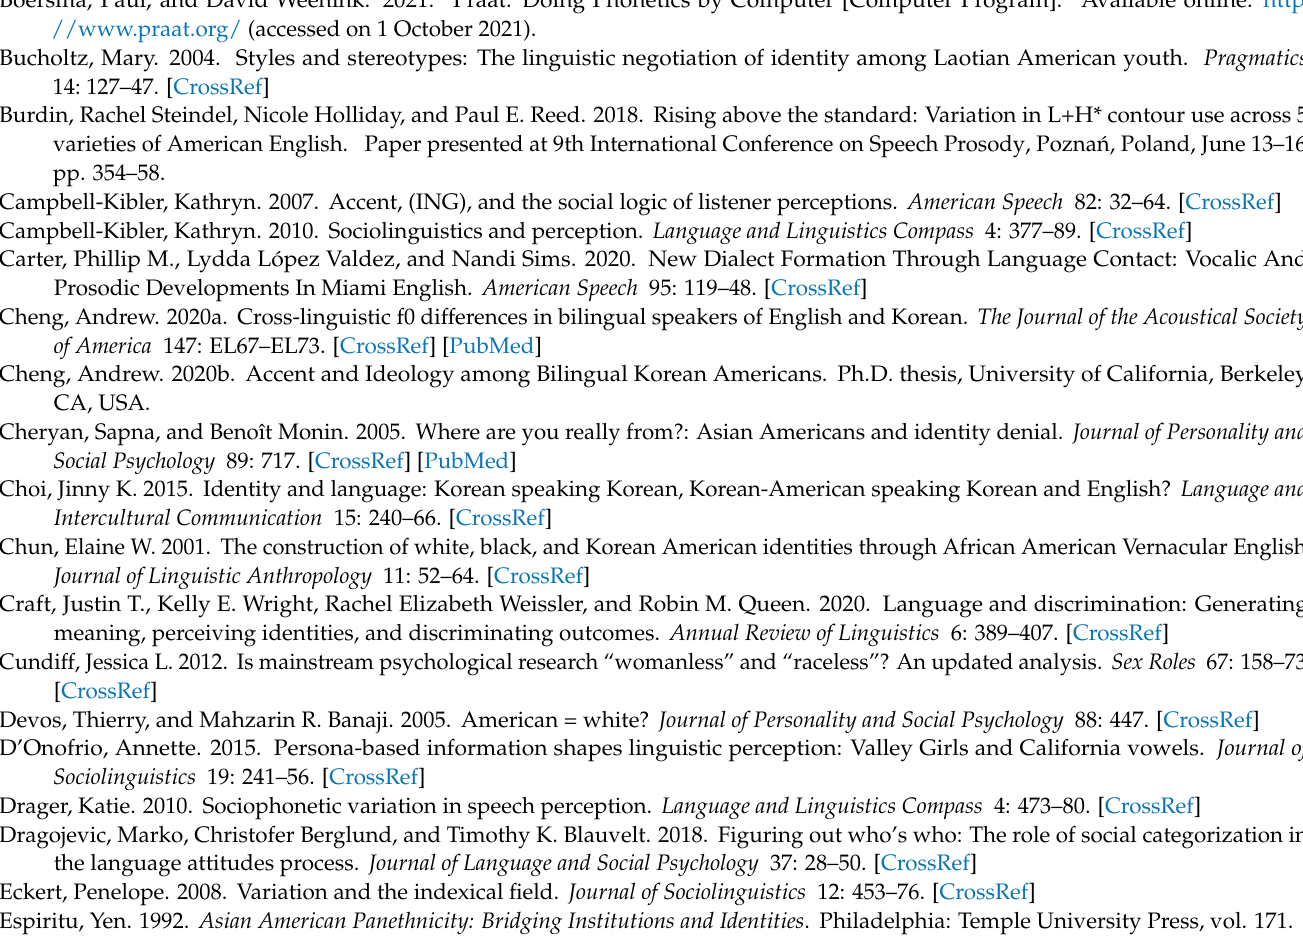
speakers separated into three groups: second generation, “early” 1.5-generation arrivals (who immigrated prior to age 6)